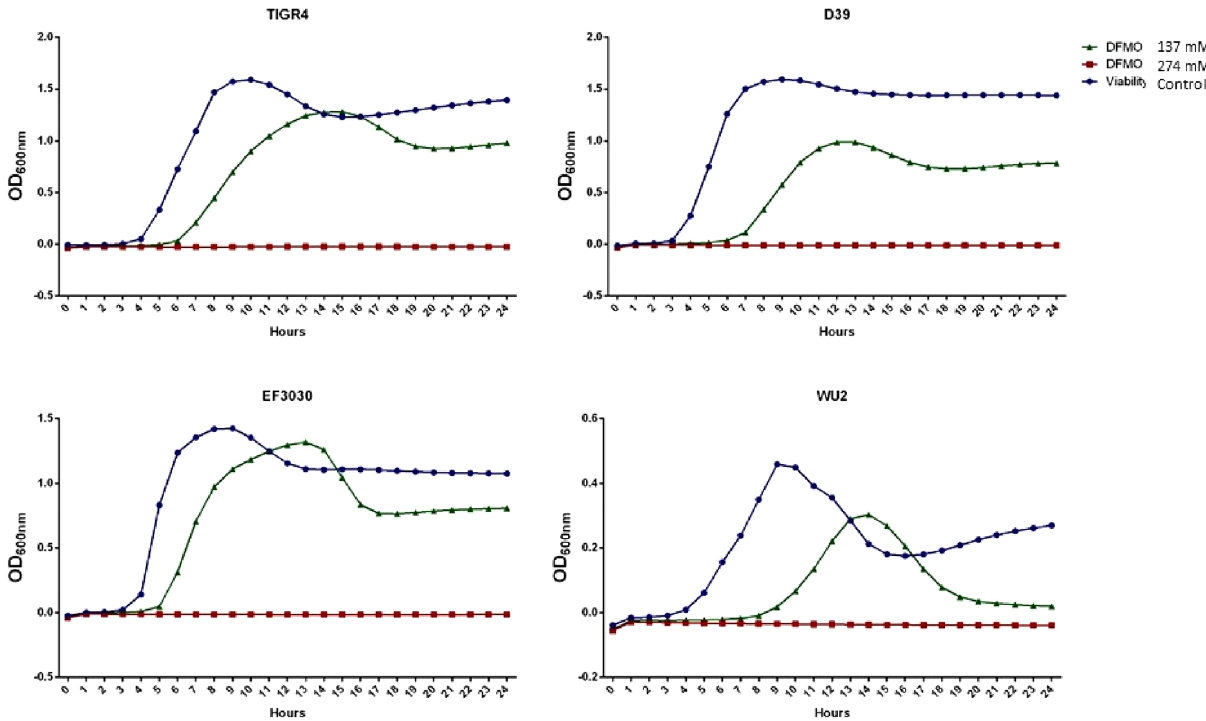
Figure 1. Susceptibility of pneumococci to DFMO. Growths of TIGR4, D39, EF3030 and WU2 strains were measured with DFMO (137 and 274 mM) and without (viability control) in a plate reader at 1 h intervals for 24 h.